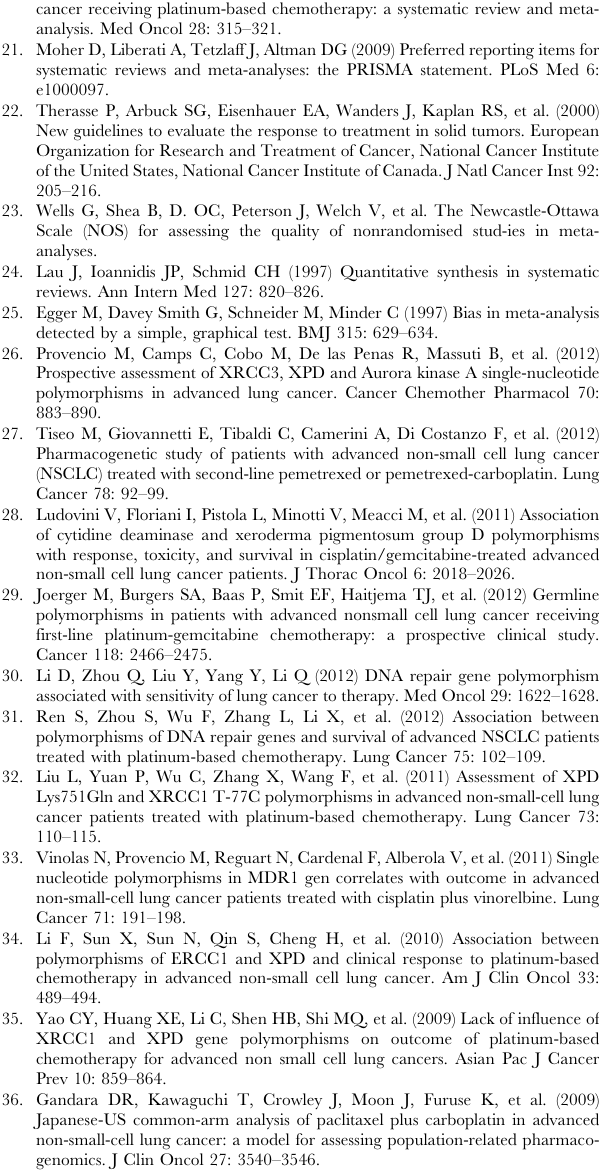
Newcastle-Ottawa